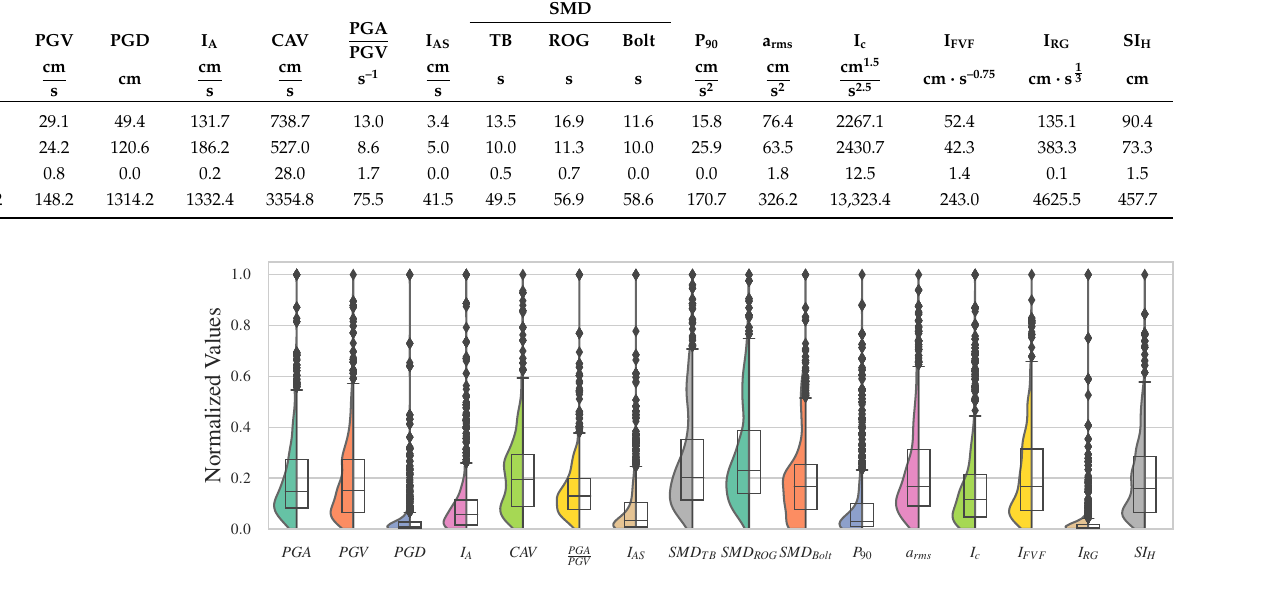
Figure 3. Violin and box plots of the